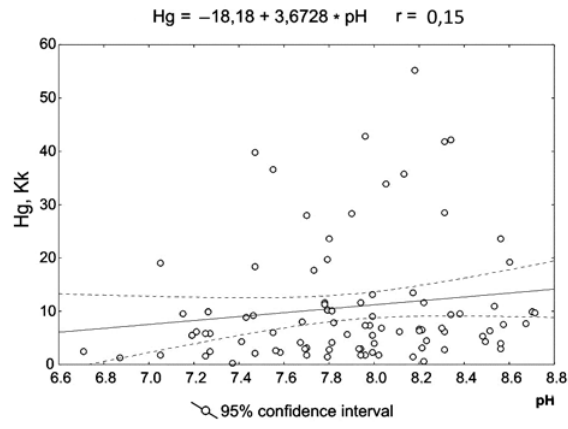
Fig. 5. Correlation ( r ) between concentration coefficient of mercury (Hg) and topsoil pH in eldership of Šnipiškės of the city Vilnius